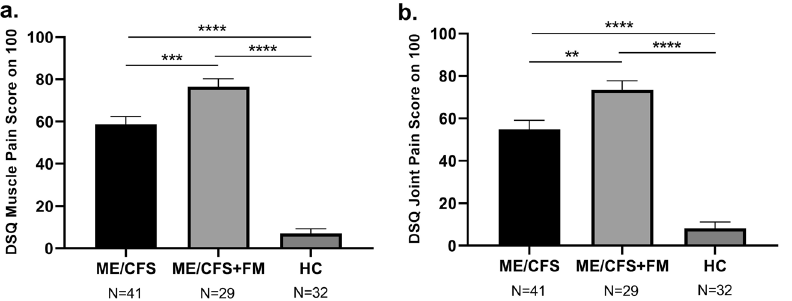
Figure 3. Muscle pain score ( a ) and joint pain score ( b ) from the DSQ questionnaire reported by individuals with ME/CFS, ME/CFS + FM and HC. One-way ANOVA followed by Tukey’s multiple comparisons test were performed to determine the significant difference in the scores between the groups. Results were considered at *P value < 0.05, **P value < 0.01, ***P value < 0.001, ****P value < 0.0001.